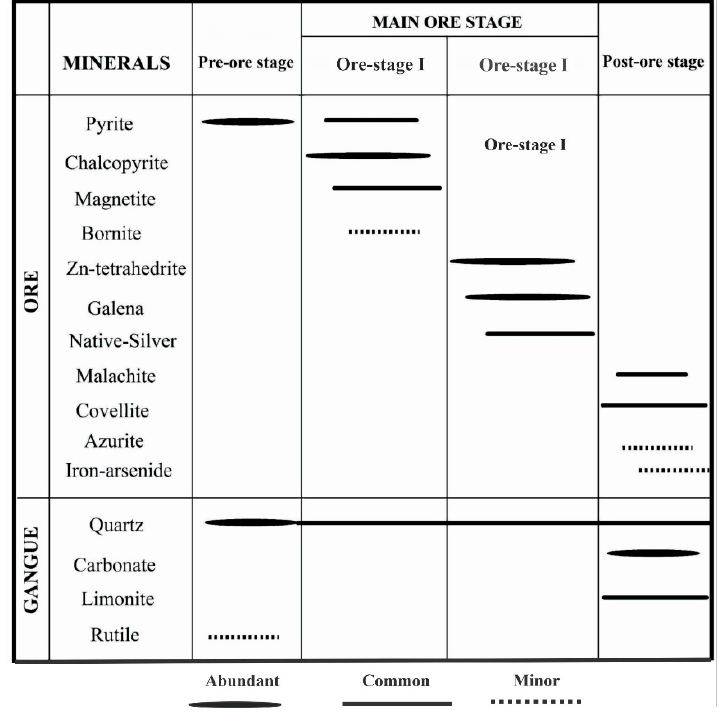
Figure 6. The paragenetic sequence of the Kargah Cu-Pb polymetallic ores.